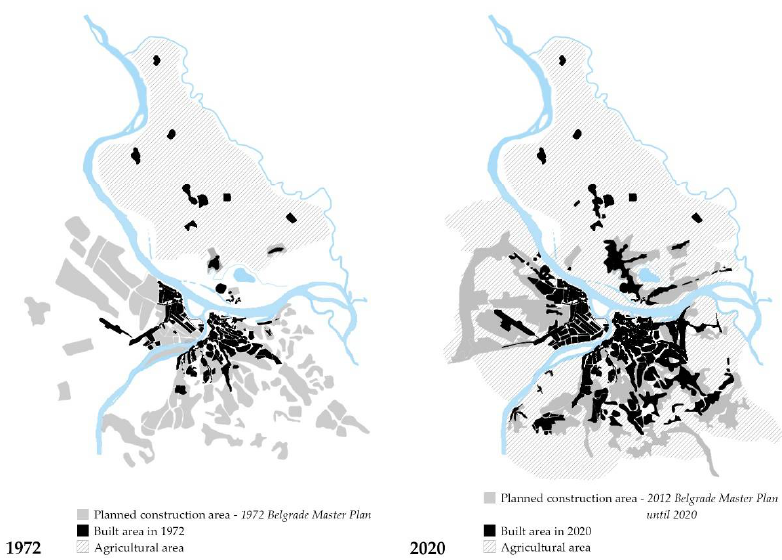
Figure 8. Morphogenesis of Third Belgrade: Cross-examination of planning framework and built area for the turning points of urban development. Source: Authors.